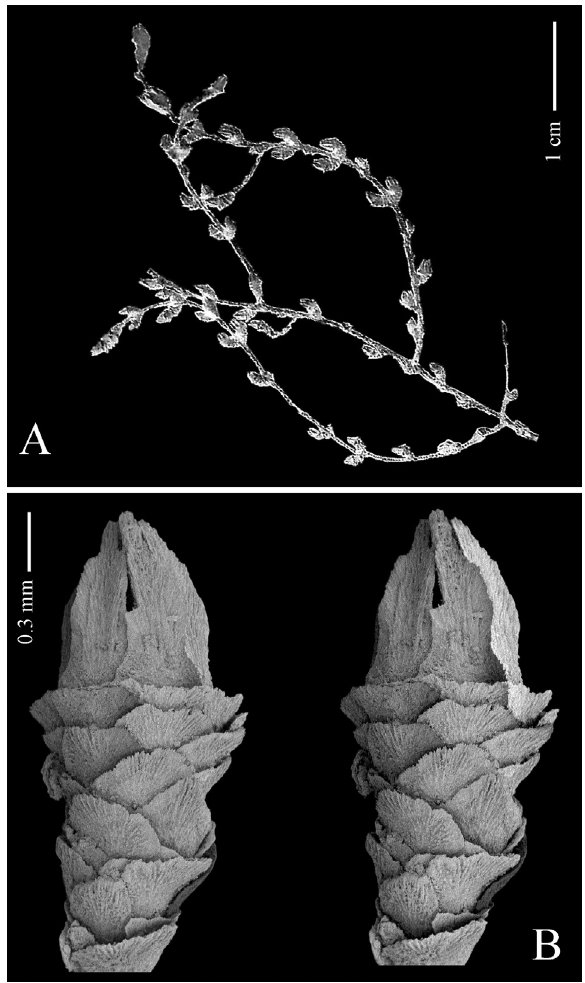
Fig . 20. – Plumarella ( Faxiella) abietina (Studer, 1894) n. comb., holotype (MCZ 4802): A, fragment of colony from Menneking, 1905: pl. 8, Fig. 7; B, polyp on abaxial view, stereo pair. [Photo: Stephen D. Cairns, NMNH, Washington].